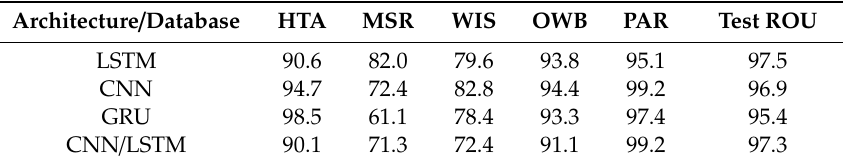
Table 10. Test accuracy results when training on the TrainROU dataset while using only accelerometer measurements.